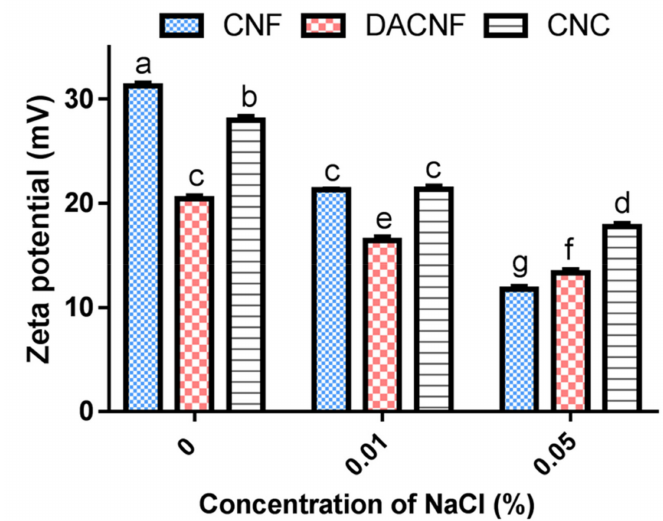
Figure 6. The e ff ect of NaCl concentration on the zeta potentials of 74 µ g / mL chitin nanofibers (CNF), deacetylated chitin nanofibers (DACNF), and chitin nanocrystals (CNC). a–g Value for each sample with di ff erent superscripts are significantly di ff erent ( p <